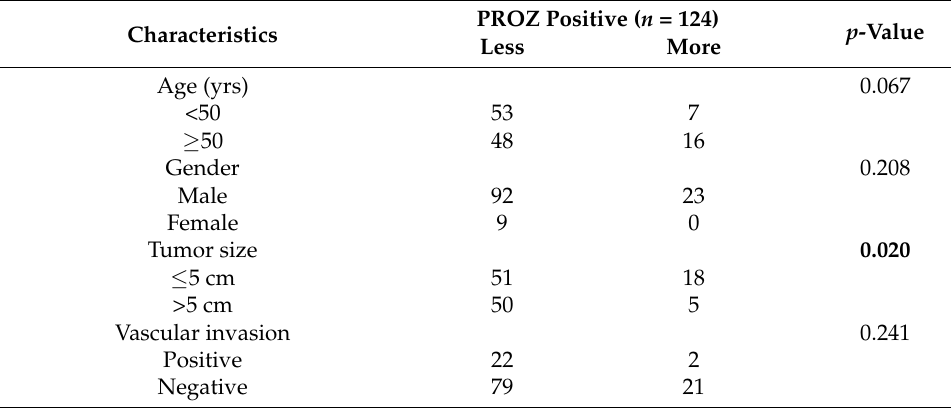
Figure 3. ( A ) PROZ expression was identified by the immunohistochemical (IHC) staining in tumor and normal liver tissues (100 × , 400 × ). ( B ) PROZ expression was identified by the immunohis- tochemical staining in tumor tissue (100 × , 400 × ). ( C , D ) Kaplan–Meier curve analysis shows the OS ( p = 0.005) and PFS ( p = 0.001) in patients with HCC showing high and low PROZ expression in tumor. Table 1. PROZ expression status in relation to patient